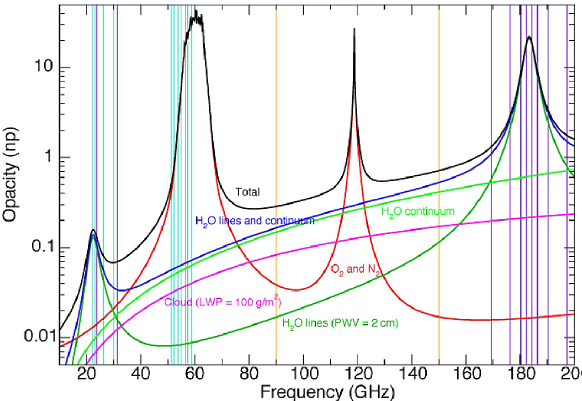
Fig. 1. The electromagnetic spectrum covered by the ARM mi- crowave radiometers for an atmosphere with PWV of 2mm and liquid water path of 100gm − 2 . Vertical lines indicate the fre- quency location of the instruments MWR and MWRP (light blue), MWRHF (yellow), GVR and GVRP